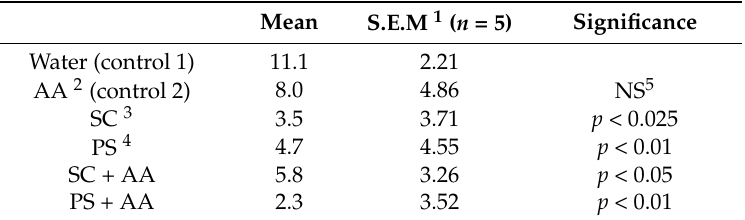
Table 1. Mean cook loss (%) of whole crabs when sodium caseinate and potato starch with and without ascorbic acid, were incorporated into the processing